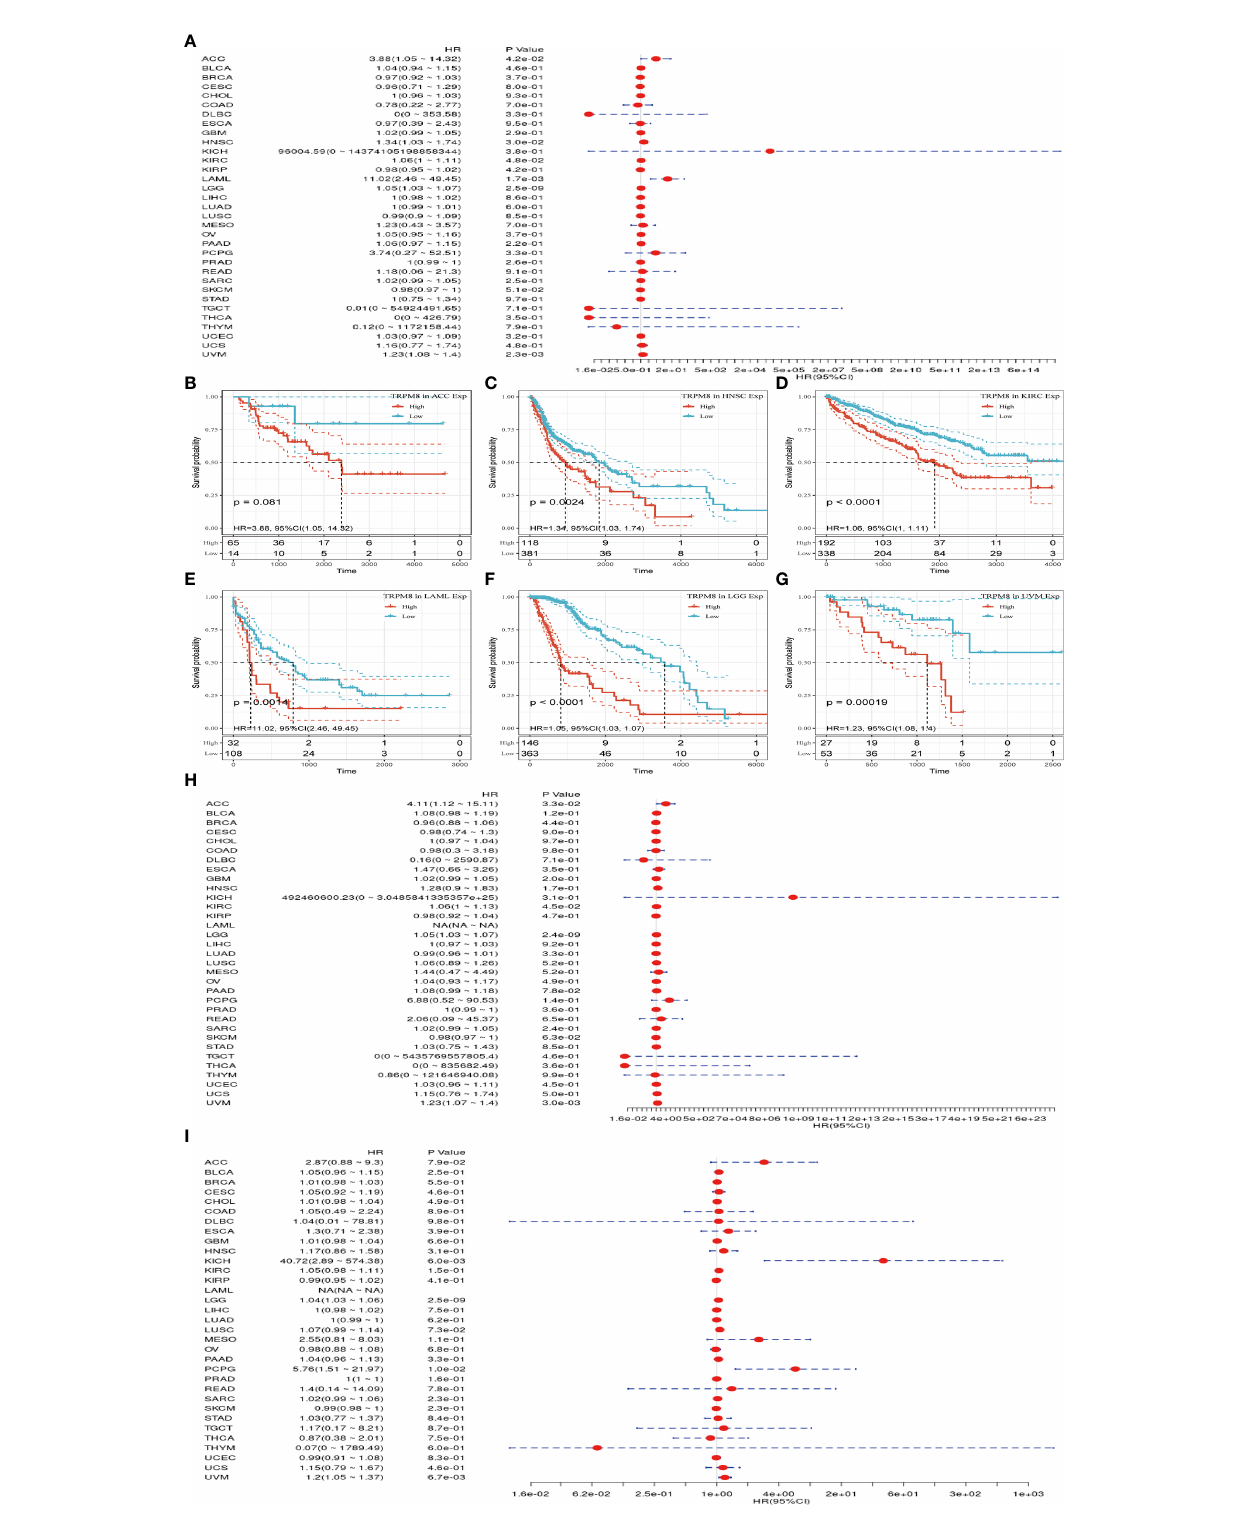
FIGURE 4 | TRPM8 levels in relation to patient survival. (A) Association with OS in 33 cancer types. (B-G) Kaplan-Meier curves showing an association between TRPM8 and OS in the six most signi fi cantly associated tumors (ACC, HNSC, KIRC, LAML, LGG, and LIHC). (H-I) Association between TRPM8 and DSS and